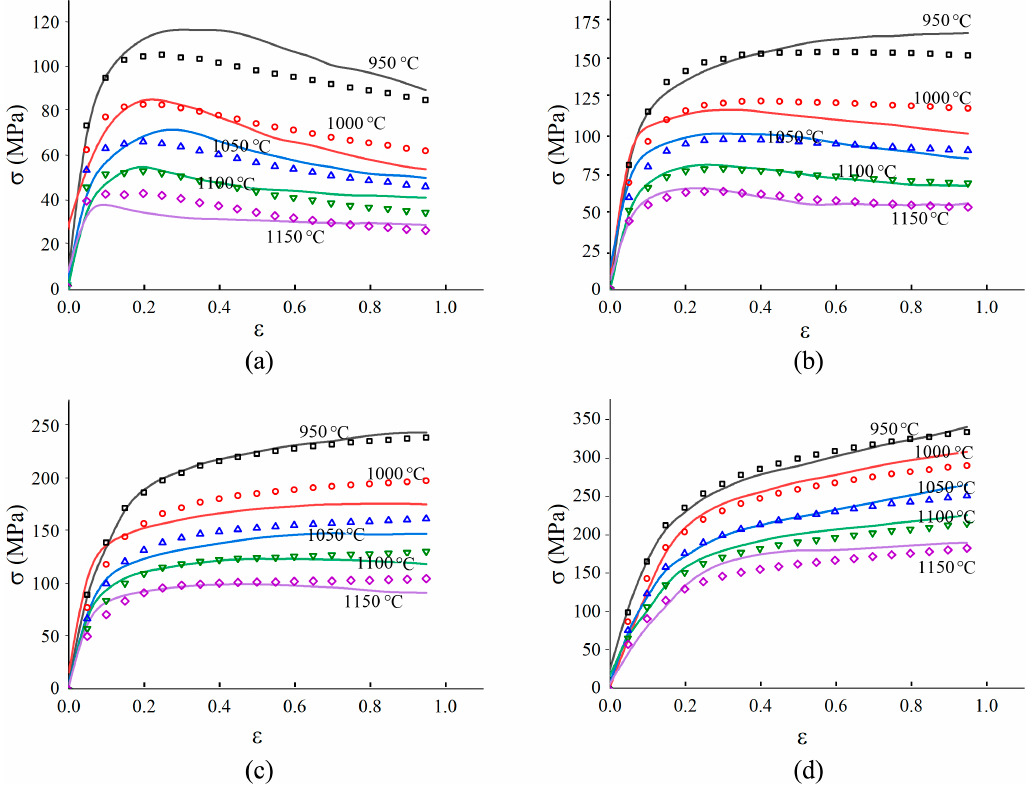
Figure 9. Comparisons of the calculated (dots) and experimental (lines) flow stress at the strain rates of ( a ) 0.01 s − 1 , ( b ) 0. 1 s − 1 , ( c ) 1 s − 1 , ( d ) 10 s − 1 .